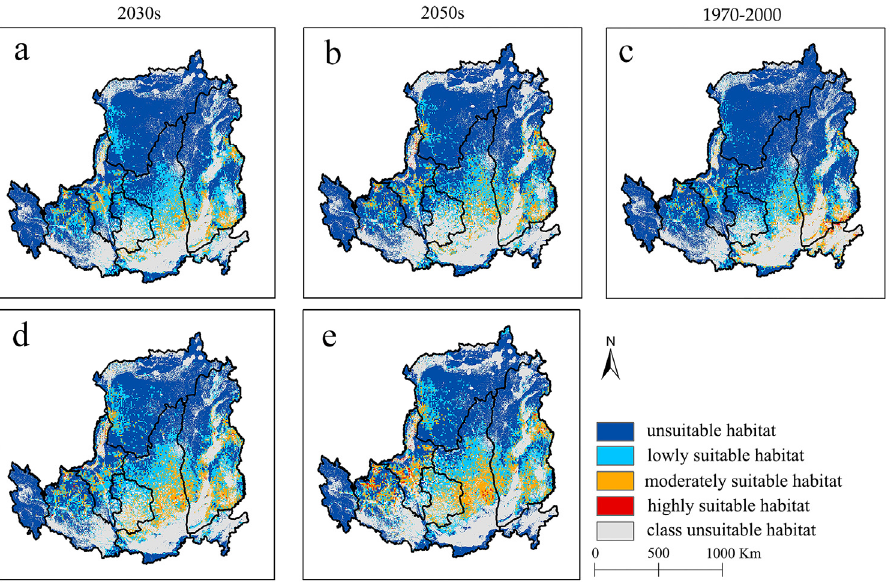
Figure 2. The spatial patterns of apple trees in the 1970–2000 ( c ) and near future under two scenarios (( a , b ) SSP1 ‐ 26, ( d , e ) SSP5 ‐ 85). According to the optimized results of the distribution of apple trees, the CUH mainly spread in the east, south, southeast, southwest, west, north, and northwest of the Loess Plateau (Figures 2 and S3). Currently, the CUH, within 1.81 × 10 5 km 2 (Figure 3), is predominantly contiguously distributed in the south, southeast, and southwest of the Loess Plateau, is sporadic in the central area, and is patchy in the west, northwest, north, and northeast; the MSH and HSH were mainly scattered in the southeast, and the LSH was mainly located in the central area (Figure 2). Compared with the 1970–2000 period, the area of the CUH expanded in different degrees in the 2030s and the 2050s under both SSP1 ‐ 26 (1.07~2.37 × 10 4 km 2 ) and SSP5 ‐ 85 (1.10~2.38 × 10 4 km 2 , Figure 3). The CUH mostly extended in the east, north, and northeast of the Loess Plateau, while the changes in the south, southeast, southwest, and west were relatively slight (Figure S3). In contrast, under the two SSPs, the distribution range of the LSH and MSH were expanded to different degrees in the south, central, and southwest areas in the near future (Figure 2, Table S2). The HSH area change trend showed a V ‐ shaped curve from the 1970–2000 period to the 2030s and the 2050s, while its area under SSP1 ‐ 26 was still lower than it was under near present climatic conditions (Table S2).